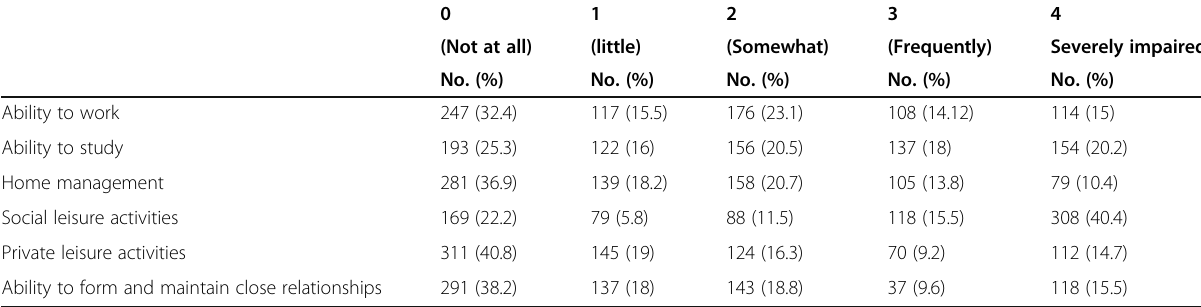
Table 2 Levels for social impairment caused by coronavirus